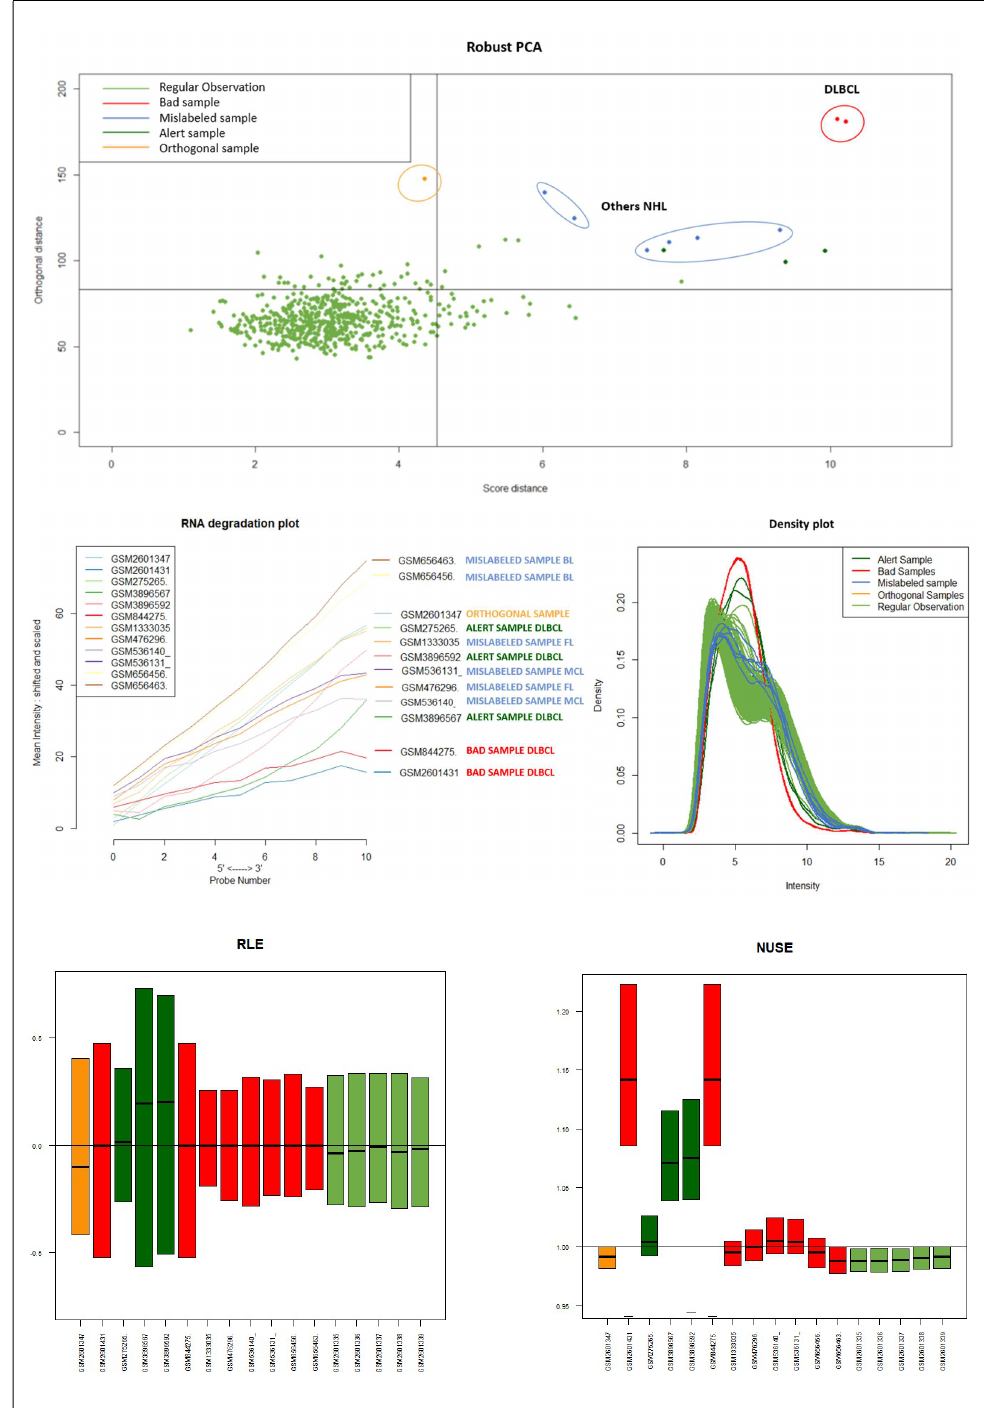
Figure A2. Summary of quality array measures for Dataset